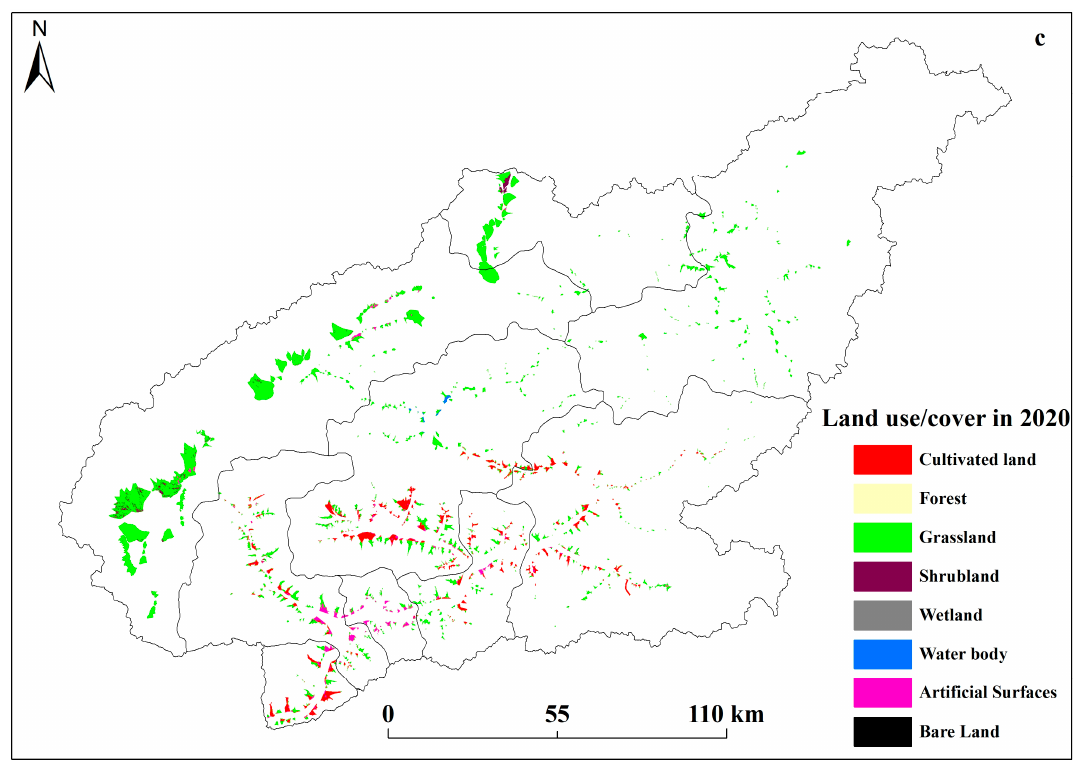
Figure 3. Spatial distribution of land use/cover in different years. ( a ). Land use/cover in 2000; ( b ). Land use/cover in 2010; ( c ) Land use/cover in 2020.